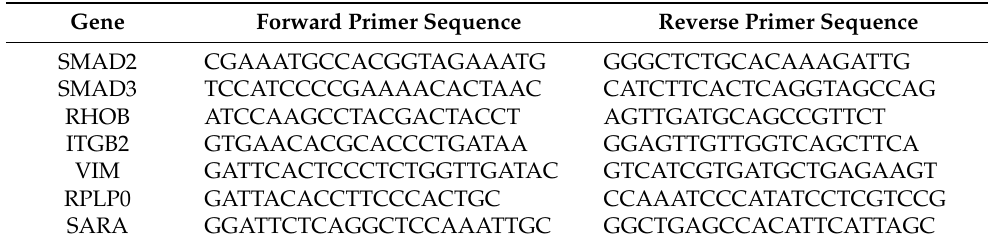
Table 2. Primer sequences used for quantitative real-time